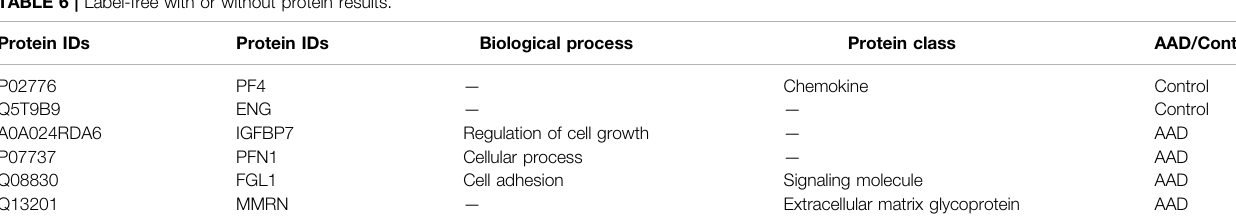
TABLE 6 | Label-free with or without protein